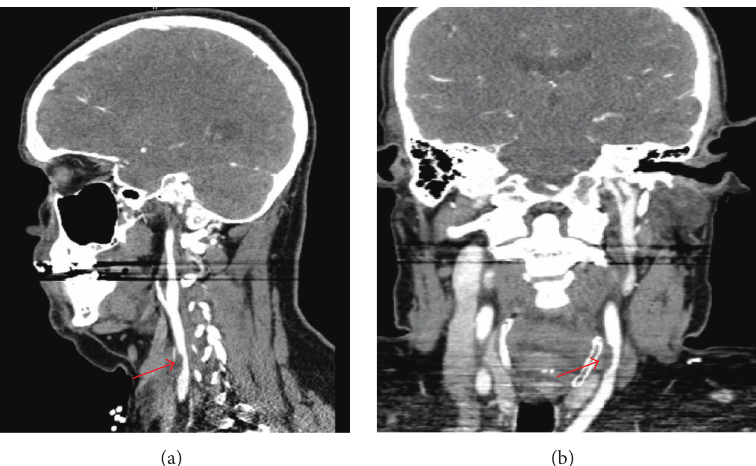
Figure 1: Sagittal (a) and coronal (b) CT angiogram of the head and neck demonstrating a 1.5 × 0.8 cm focal adherent mural thrombus (red arrows) in the left common carotid artery 4 cm proximal to the bifurcation resulting in less than 50% stenosis of the luminal diameter.